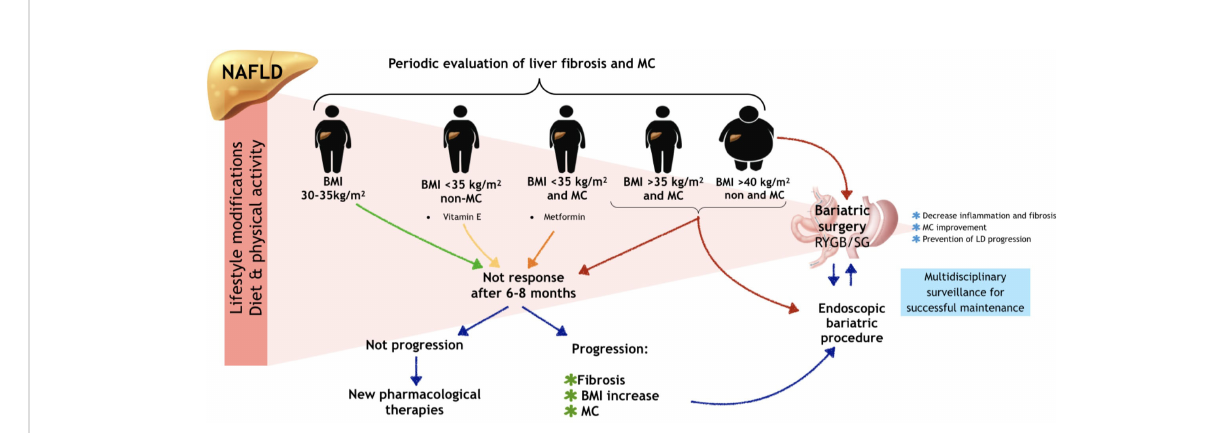
FIGURE 1 Fibrosis evaluation and NAFLD treatment in obese patients. NAFLD, non-alcoholic fatty liver disease; BMI, body mass index; MC, metabolic comorbidities; LD, liver disease. Patients who no response of fi rst line of treatment (lifestyle modi fi cations) after 6-8 months should be evaluated for progression of liver disease; in patients without progression new pharmacological therapies could be considered; in patients with liver disease progression endoscopic bariatric and metabolic therapies could be considered as an initial bariatric intervention, as well as in patients with BMI > 40 kg/m2. In all obese patients, liver fi brosis and metabolic comorbidities should be evaluated periodically. Lifestyle modi fi cations should be at all time intervention in NAFLD patients.